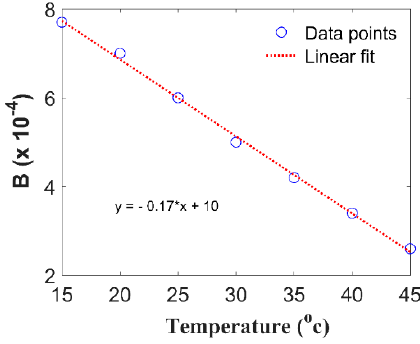
Figure 5. Fiber birefringence as a function of temperature for the optimized design with d = 1.2 μ m, Ʌ 1 = 2.6 μ m, Ʌ 2 = 3.9 μ m, D 1 = 0.8 μ m, and D 2 = 0.5 μ m. Λ 1 = 2.6 µ m, Λ 2 = 3.9 µ m, D 1 = 0.8 µ m, and D 2 = 0.5 µ